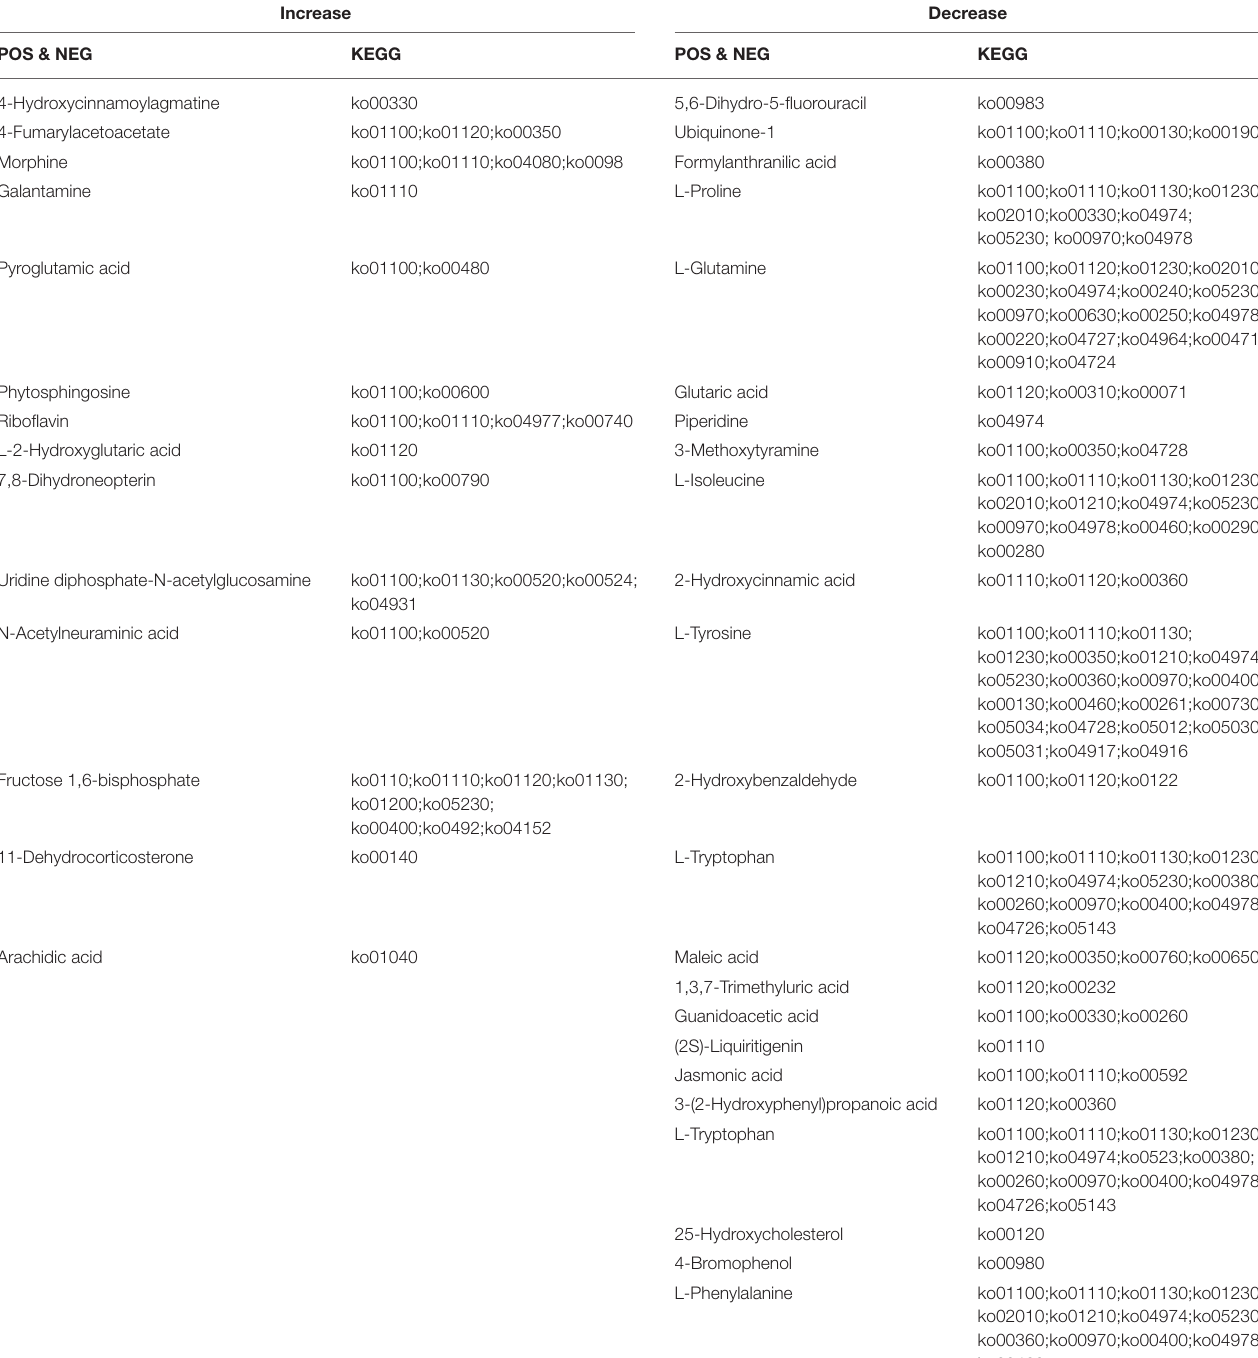
TABLE 2 | Metabolites changed after FMT and related signal pathways in this case.